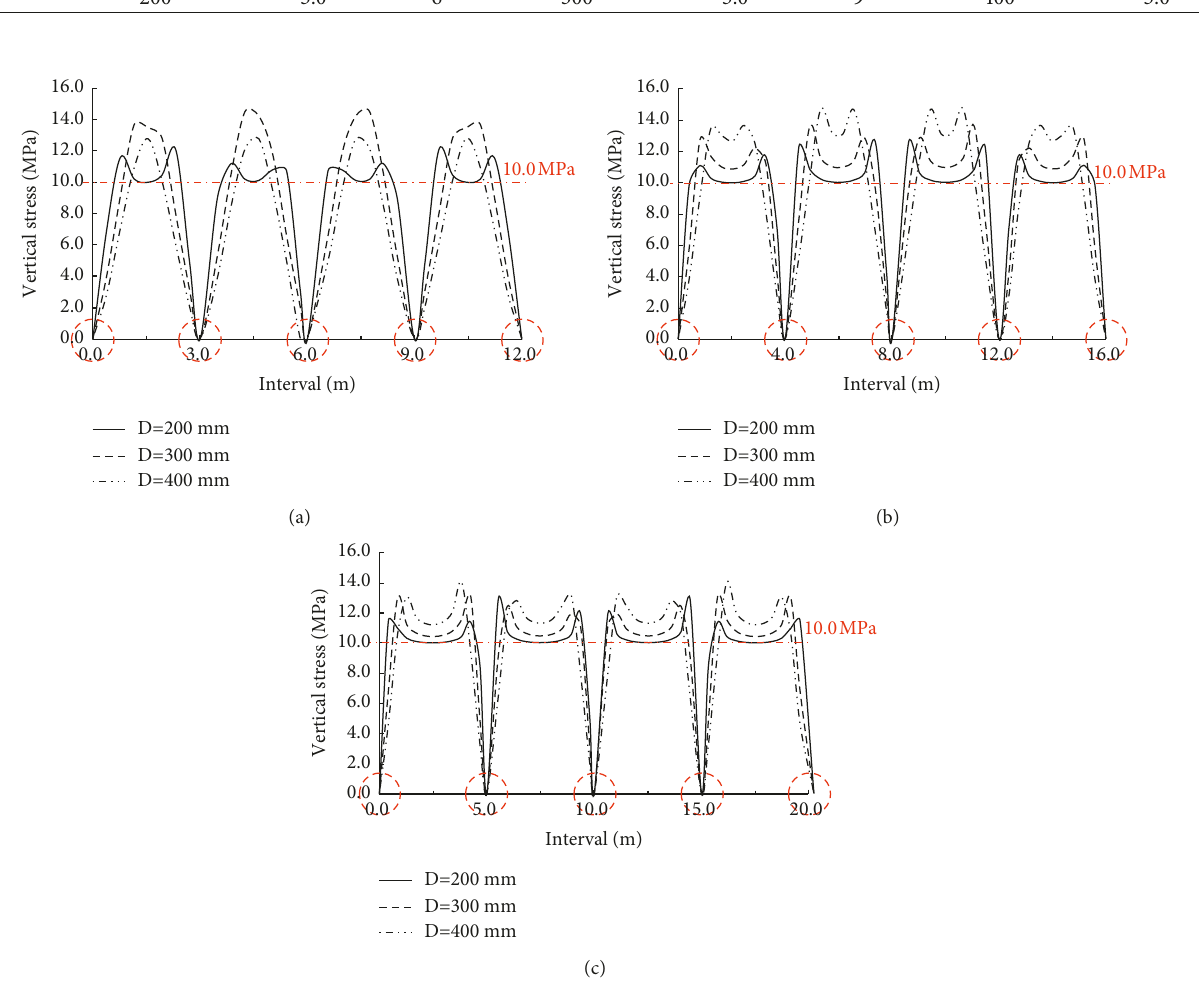
Figure 16: The vertical stress distribution laws under different diameters and intervals. (a) The interval is 3.0m; (b) the interval is 4.0m; (c) the interval is 5.0m.